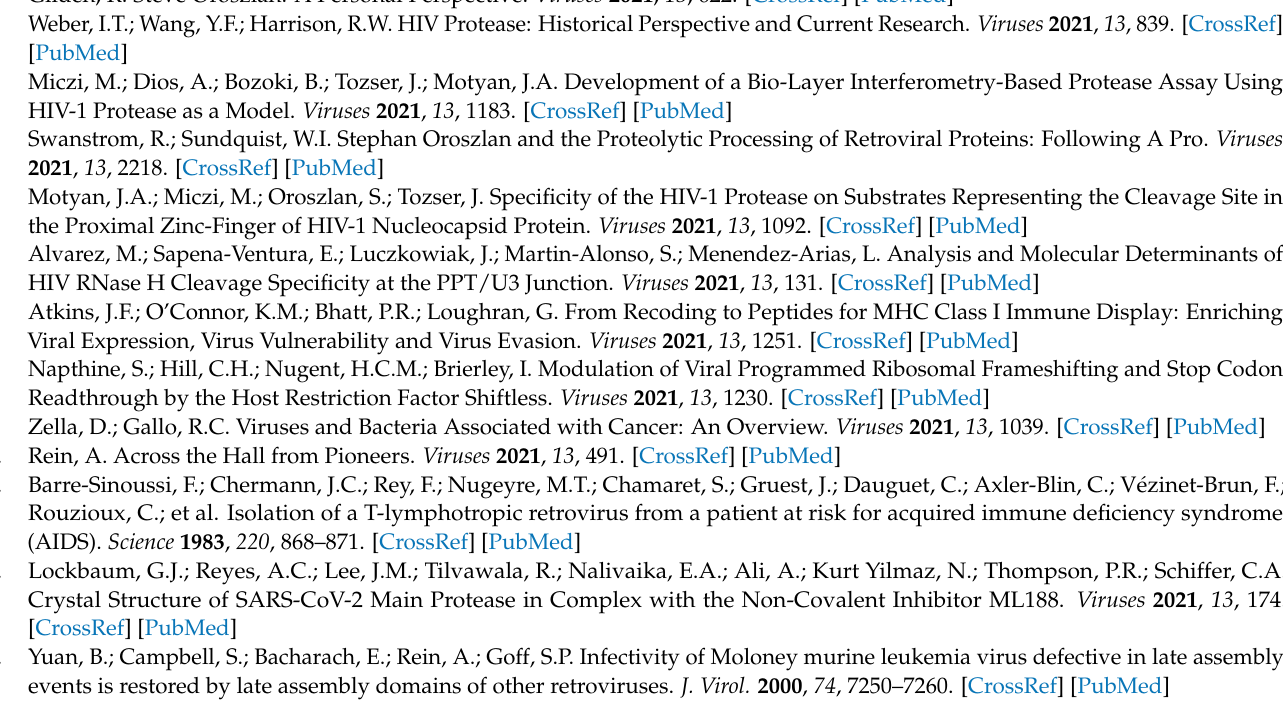
Figure 1. Steve Oroszlan in his element at meetings. ( A ) With Reuben Harris of the University of Minnesota; ( B ) with Steve Hughes, Gisela Heidecker, and Dave Derse, his colleagues at the NCI HIV Drug Resistance Program. Photos courtesy of Luis Menendez-Arias.